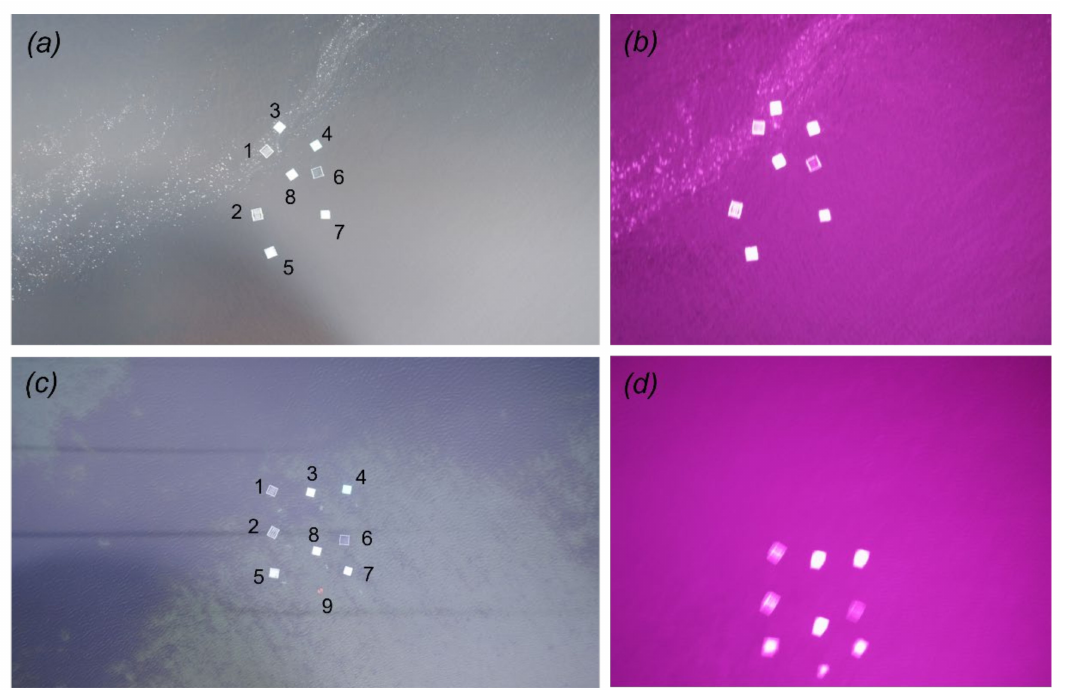
Figure A1. Images taken during the four surveys in ( a ) 1 April, RGB, ( b ) 1 April, NIR, ( c ) 3 August, RGB, ( d ) 3 August, NIR. Numbers indicate targets: 1-small PET, 2-large PET, 3-EPS white, 4-EPS blue,